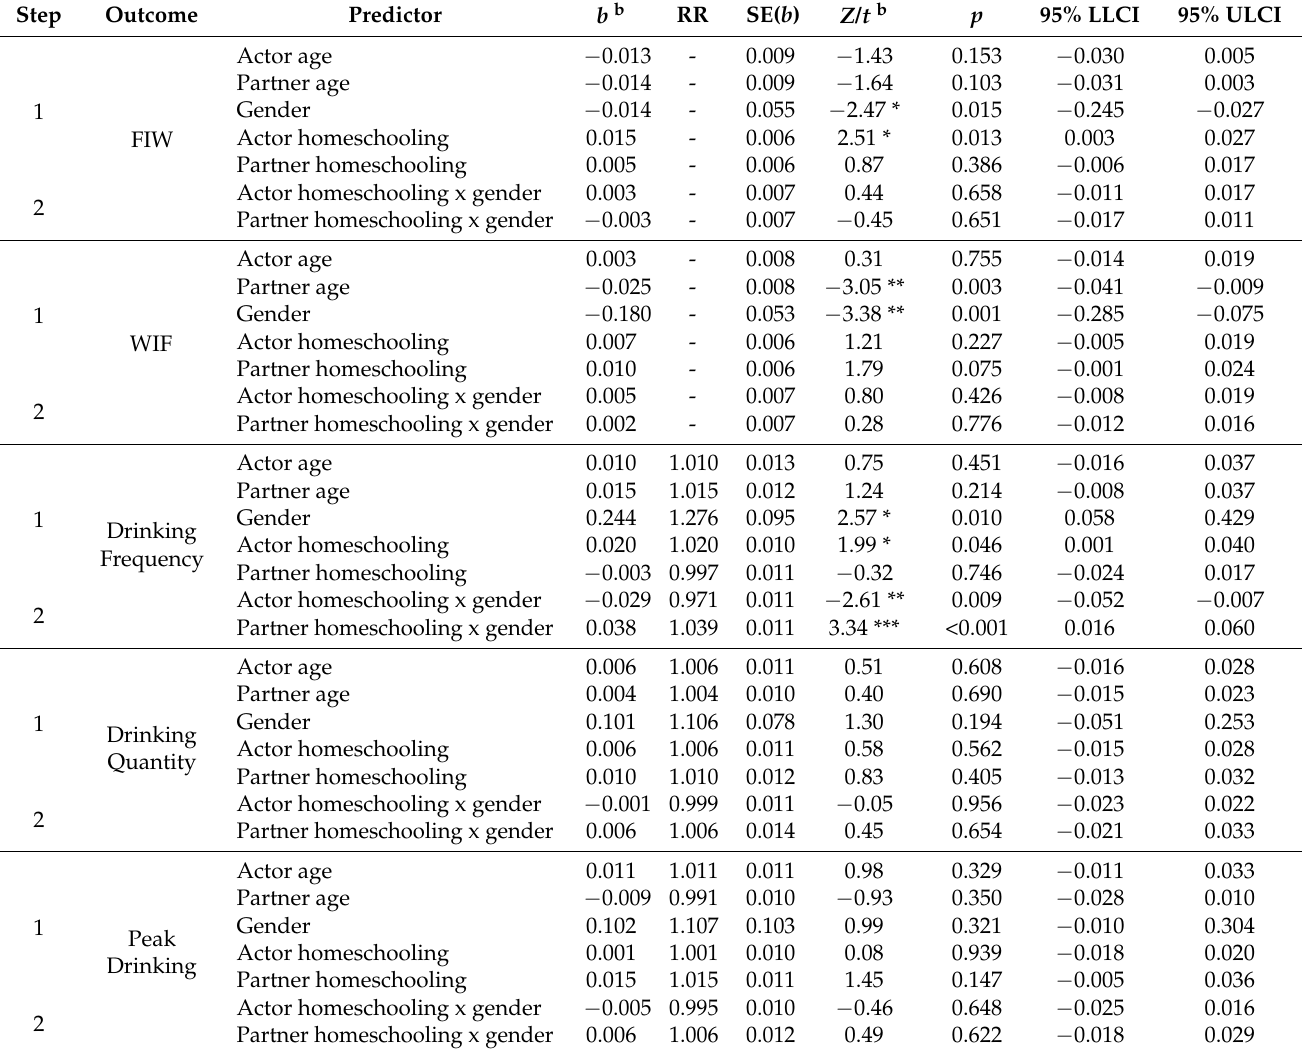
Table 4. Actor–Partner Interdependence Models (Distinguishable Dyads) Examining Partners’ Hours spent Homeschooling on Work Family Conflict and Alcohol Use and Interactions with